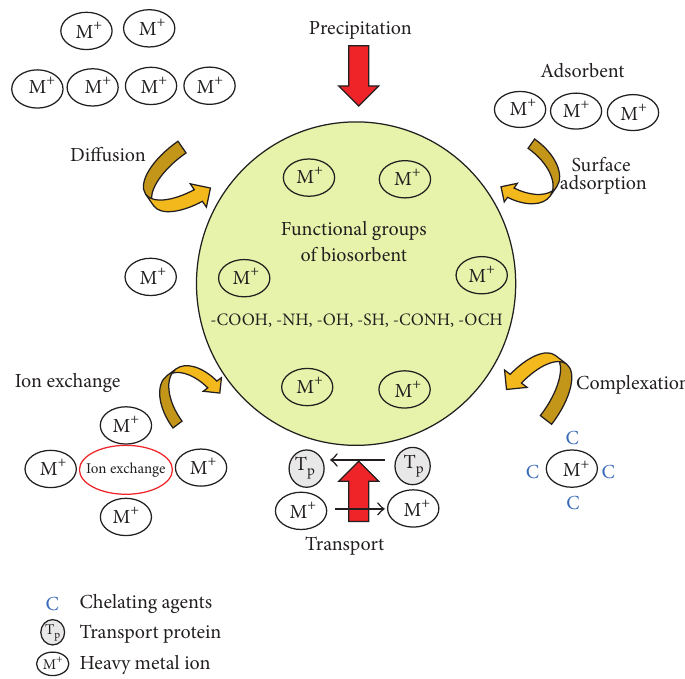
Figure 1: Biosorbent